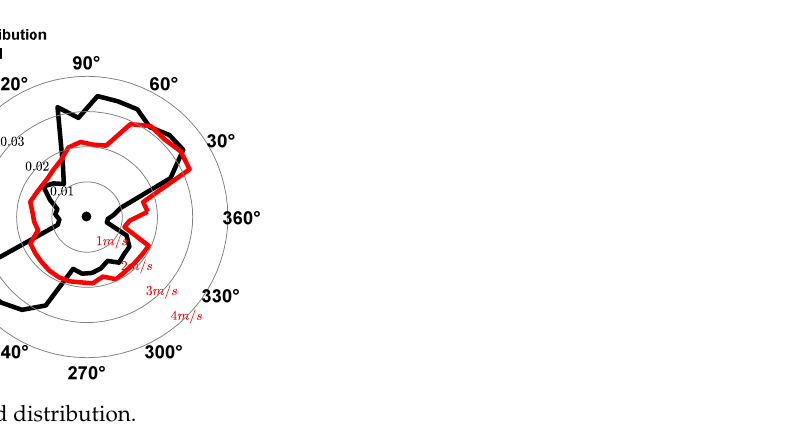
The population distribution is modeled with population density data. Cooperating Figure 5. Wind distribution.